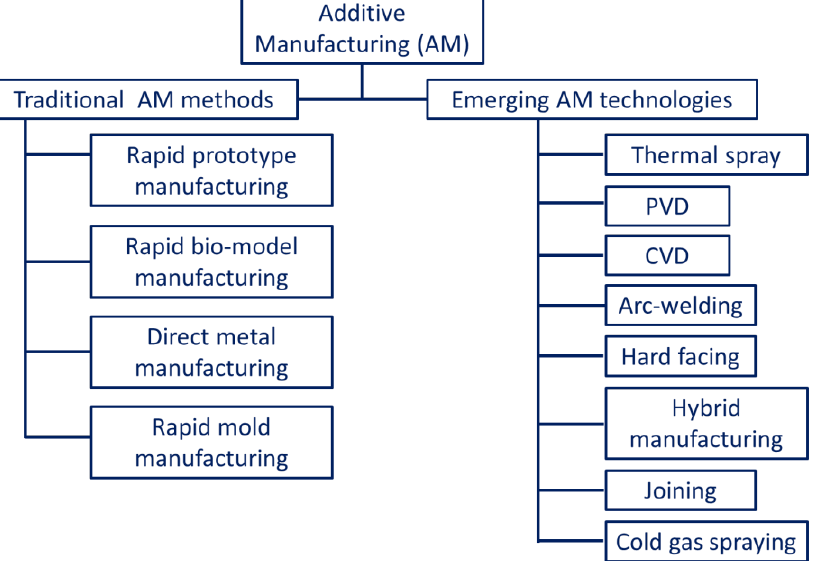
Figure 1. Generalized classification of the different additive manufacturing technologies.